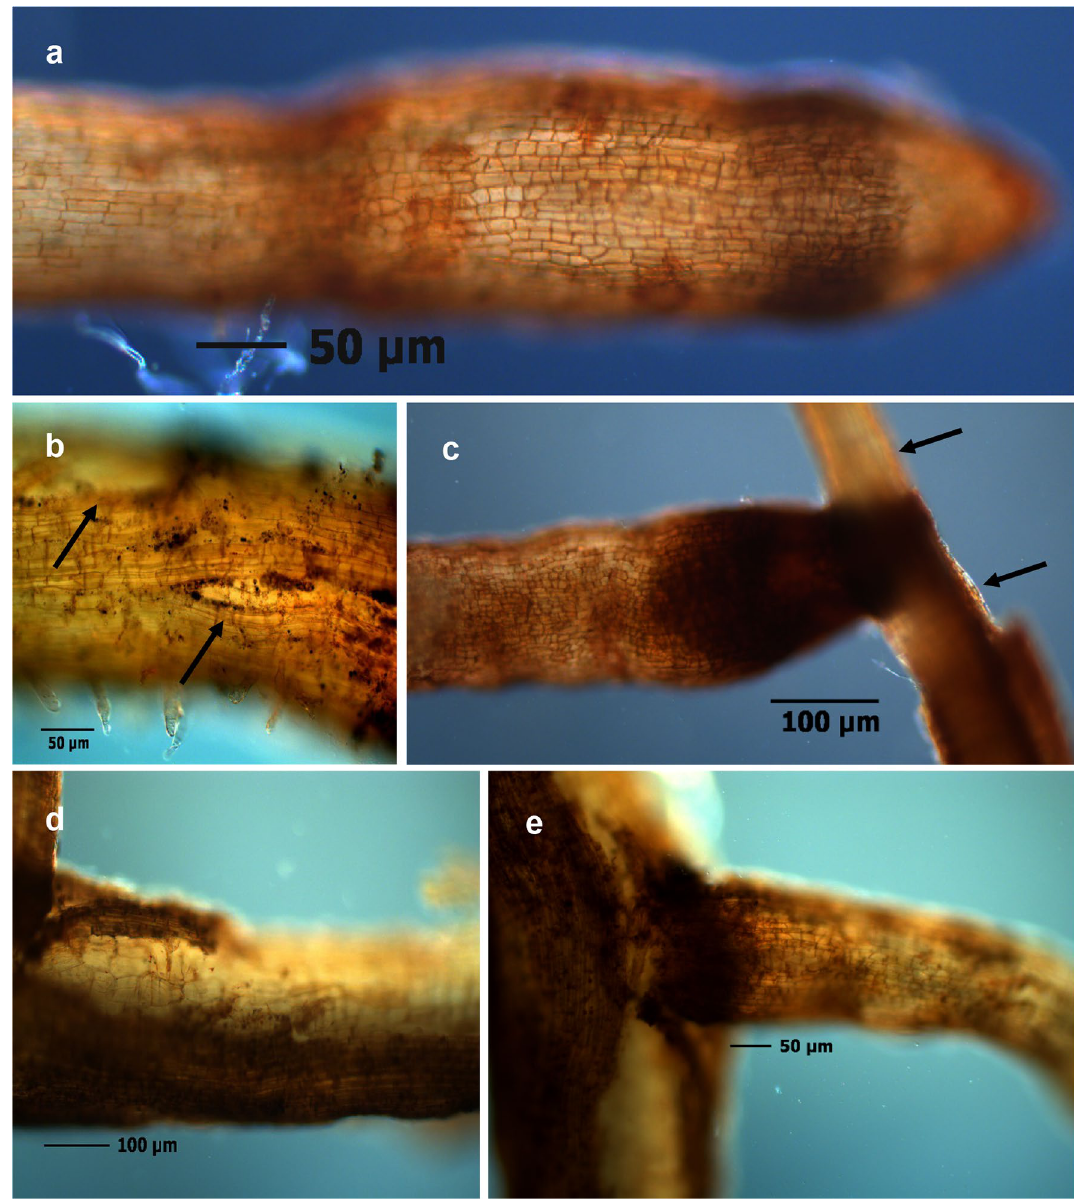
Figure 2. Structural damages of outer tissue layers in fine roots of R. corymbifera ‘Laxa’, 9 weeks after cultivation in replant diseased soils from site Heidgraben ( a , b , d ) and site Sangerhausen ( c , e ). Constrictions in newly formed roots ( a ), ruptures in and loss of cortex tissue (arrows) next to branching lateral roots ( b – e later black. The infection process led to the impairment of host cells with disintegration of cell components, browning, necrotic collapse (Fig. 7a–c), and blackening of whole cells, ultimately extending to neighbouring cells. Further, occasionally brown to black intracellular inclusion bodies of different size were detected in infected areas. Another fungus with impressive production of melanised arthroconidia on the root surface developed rough mycelial structures within the outer cell layers of fine roots of two plants (treatment H ut) (Fig. ESM 5a,b). There- fore, it is classified as an endophytic fungus; however, its identity has yet to be determined. After nine weeks of cultivation, mycorrhiza colonisation was easily detected with FUN1 cell staining due to fluorescent arbuscular structures in the cortex cells (Fig. ESM 6). In the brightfield analysis, typical appressoria, distinct massive penetration sites, and intracellular coiled hyphae in the first cortex cell layers were visible, but only in healthy appearing root segments grown in untreated soils from Heidgraben as well as from Sangerhausen. Dark septate endophytes (DSE) occasionally colonised fine roots of untreated variants (H ut and S ut, respec- tively) and developed microsclerotic cell groups (Fig. ESM 7). Curved septate macroconidia with the appearance of those belonging to Fusarium oxysporum and F. solani were not visually detectable, but the isolation of these pathogens from tissue with CF structures implies their existence in replant diseased fine roots that had been